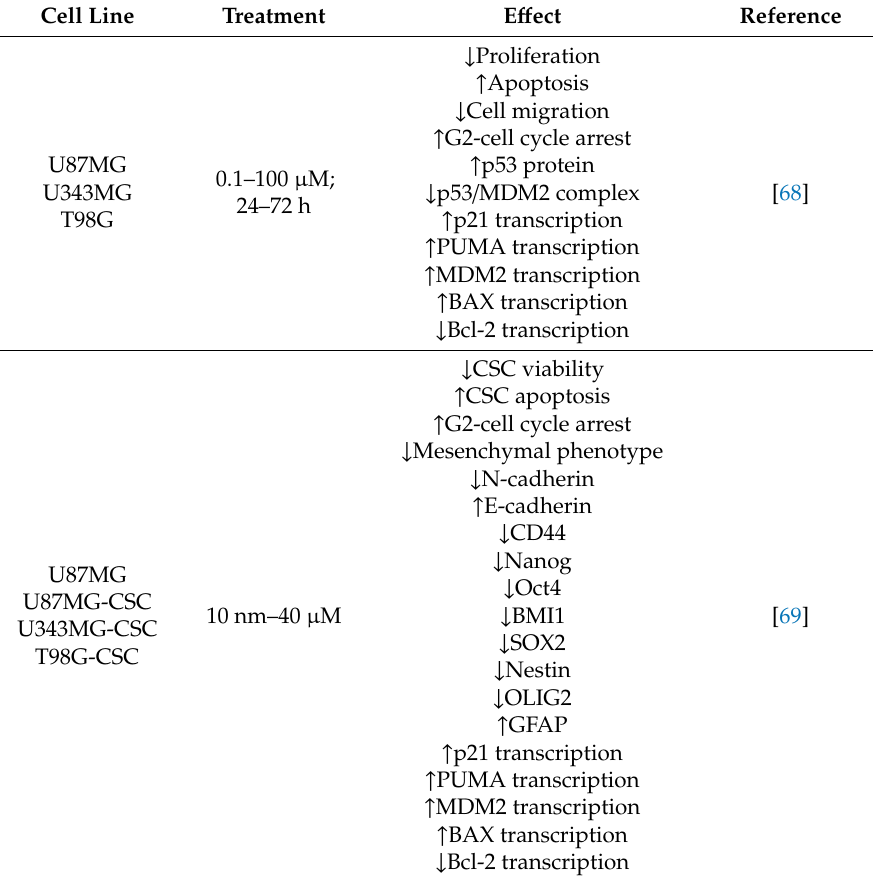
Table 8. E ff ects of carnosol on brain cancer in